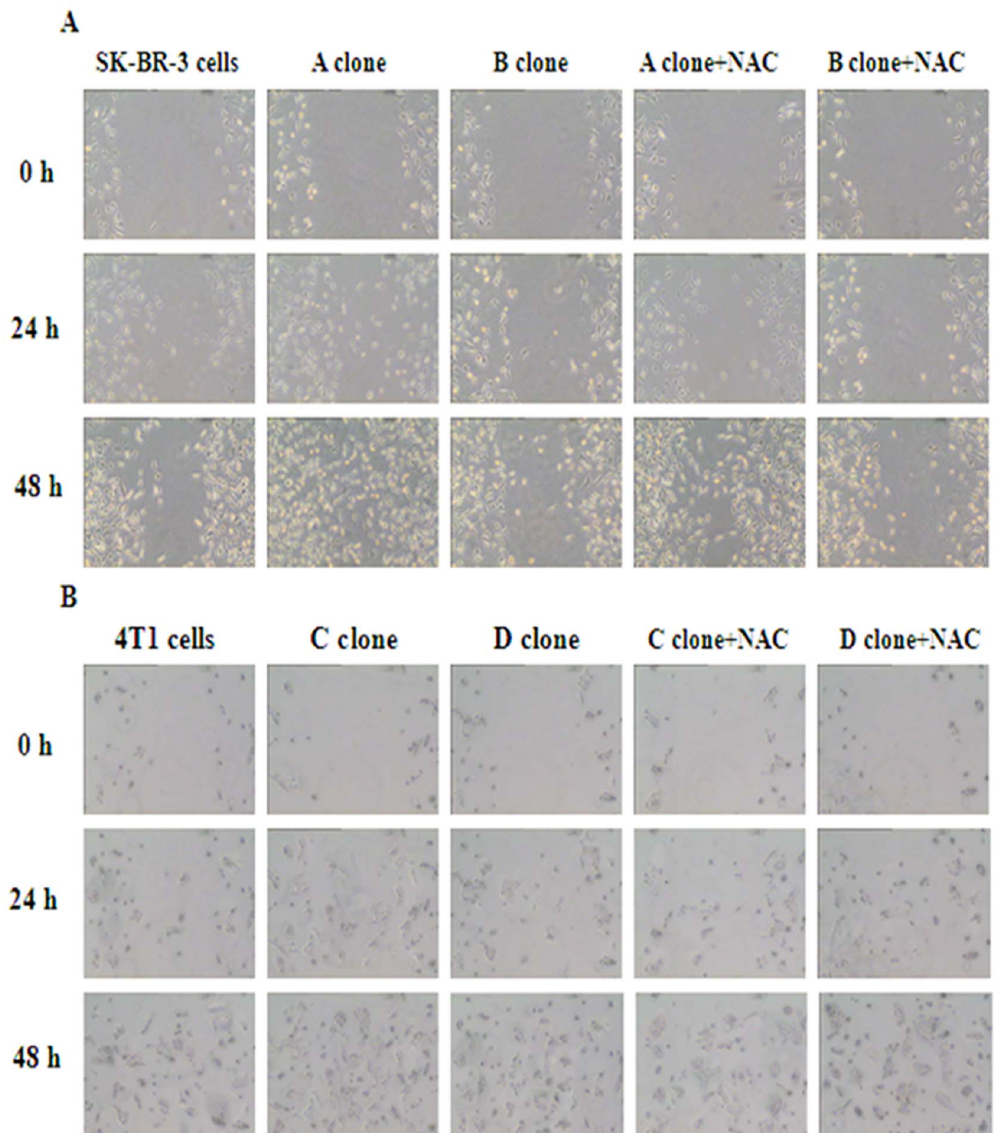
Figure 3. The migration capacity of subclones and their parental cells was measured by wound healing assay. A–B, The subclones migrated faster than the parental cells SKBR3 cells (A) and 4T1 cells (B). NAC was able to effectively inhibit the migration of the